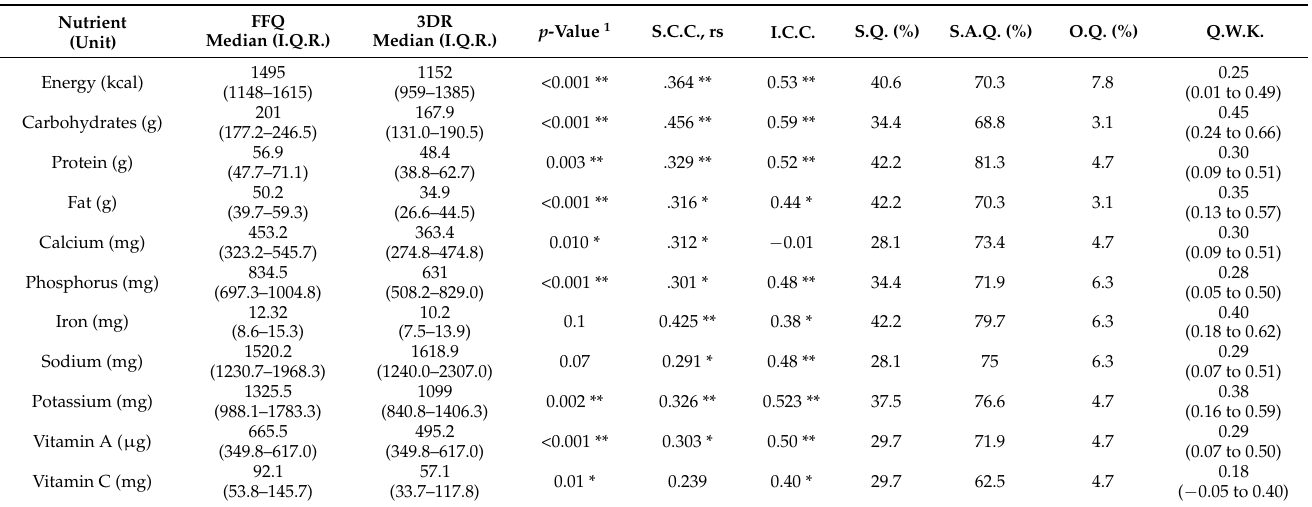
Table 4. Comparison of nutrient intakes and quartiles joint classifications between food frequency questionnaire (FFQ) and 3-day diet recall (3DR) (n =